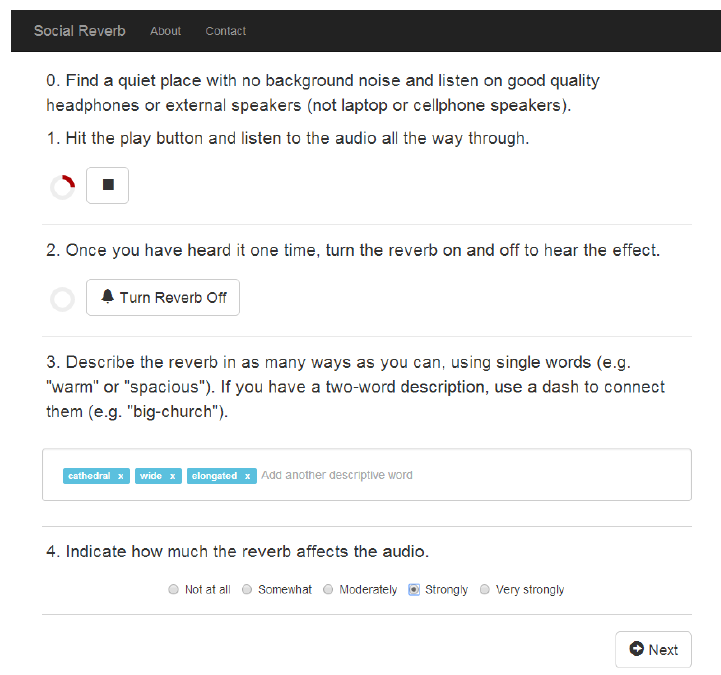
Figure 4. SocialReverb: Participants are asked to listen to a dry recording, then a recording with an audio effect applied, and then describe it in their own words. In the second stage, they are asked to check off words that other participants contributed that they agree also describe the audio effect. Screen capture created by the authors.